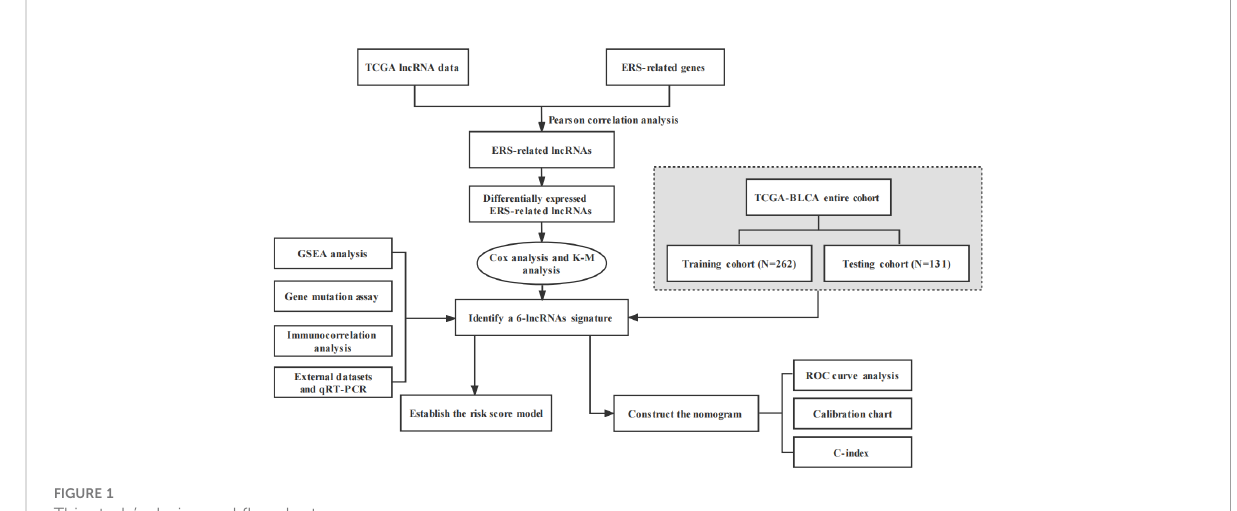
FIGURE 1 This study ’ s design and fl owchart.